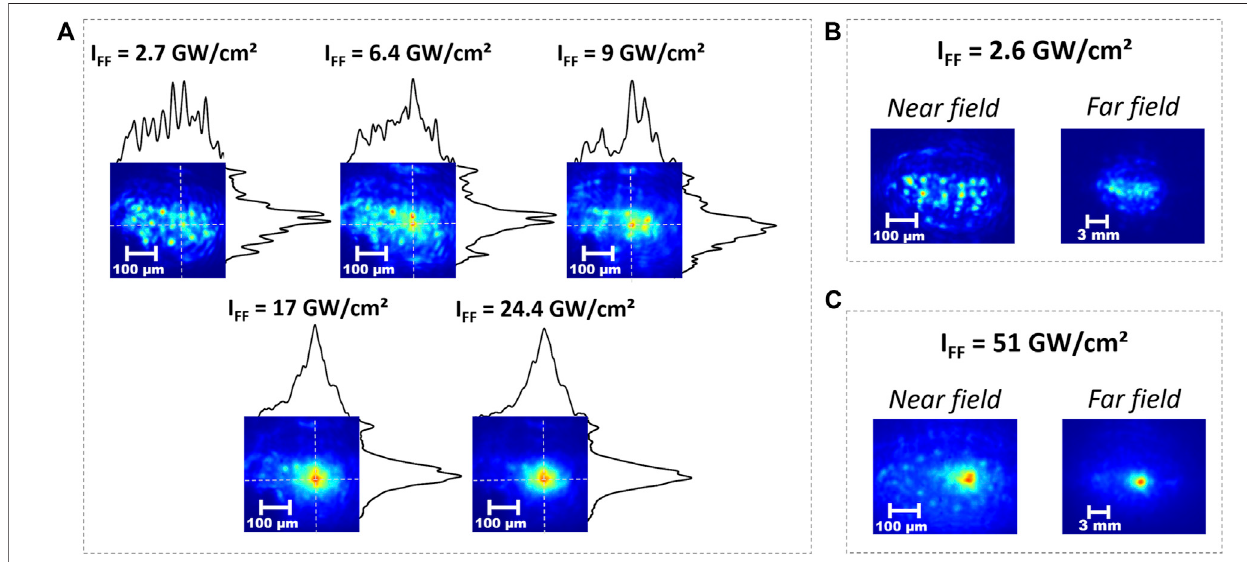
FIGURE5|(A) — near fi eld-imagesoftheSHbeamattheoutputfaceofthePPLNcrystalfordifferentpumpintensities.Nearandfar- fi eldsofSHbeamsfor (B) I FF (cid:1) 2.6 GW/cm 2 , (C) I FF (cid:1) 51 GW/cm 2 . The scale in the far- fi eld image is proportional to the spatial spectrum and it refers to the experimental setup described in Methods. These experimental results refer to a crystal temperature T (cid:1) 60 ° C.